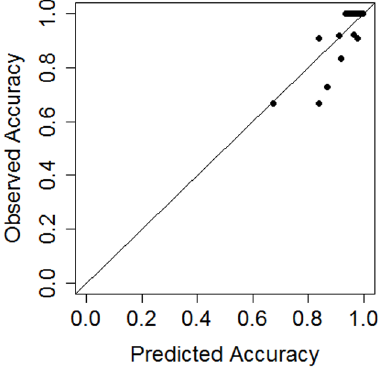
Figure 4. Model performance. Model predictions of average accuracy for 20 test print pairs plotted against observed average accuracy.